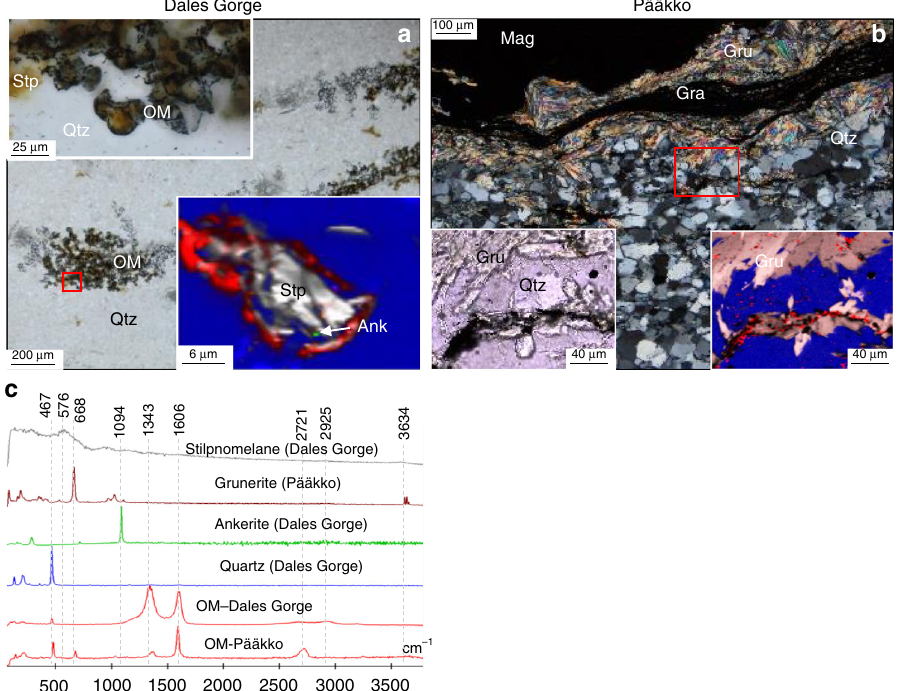
Fig. 3 Organic matter in iron-clays from ferruginous chert. a TL image of organic-matter and stilpnomelane layers in an Fe-rich chert from the Dales Gorge formation. Top-left inset is a TL image of the boxed area, and top-right inset a Raman image of the boxed area, showing organic matter around stilpnomelane. b Cross-polar image of graphite within grunerite layers in the sulphidic Pääkkö iron-formation. Bottom left inset is a TL image of the boxed area and bottom right inset is a Raman image of the boxed area showing graphite occurring predominantly within prograde grunerite. c Representative Raman spectra for this fi